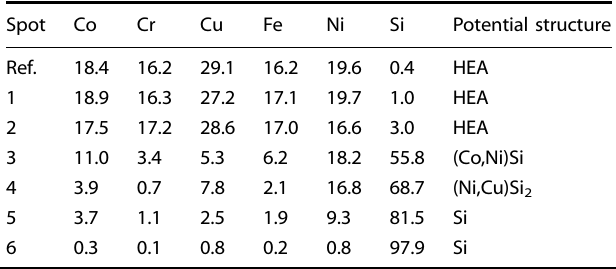
Table 2. Concentration (at%) determined by STEM-EDS and potential structure of the spots denoted in Fig.